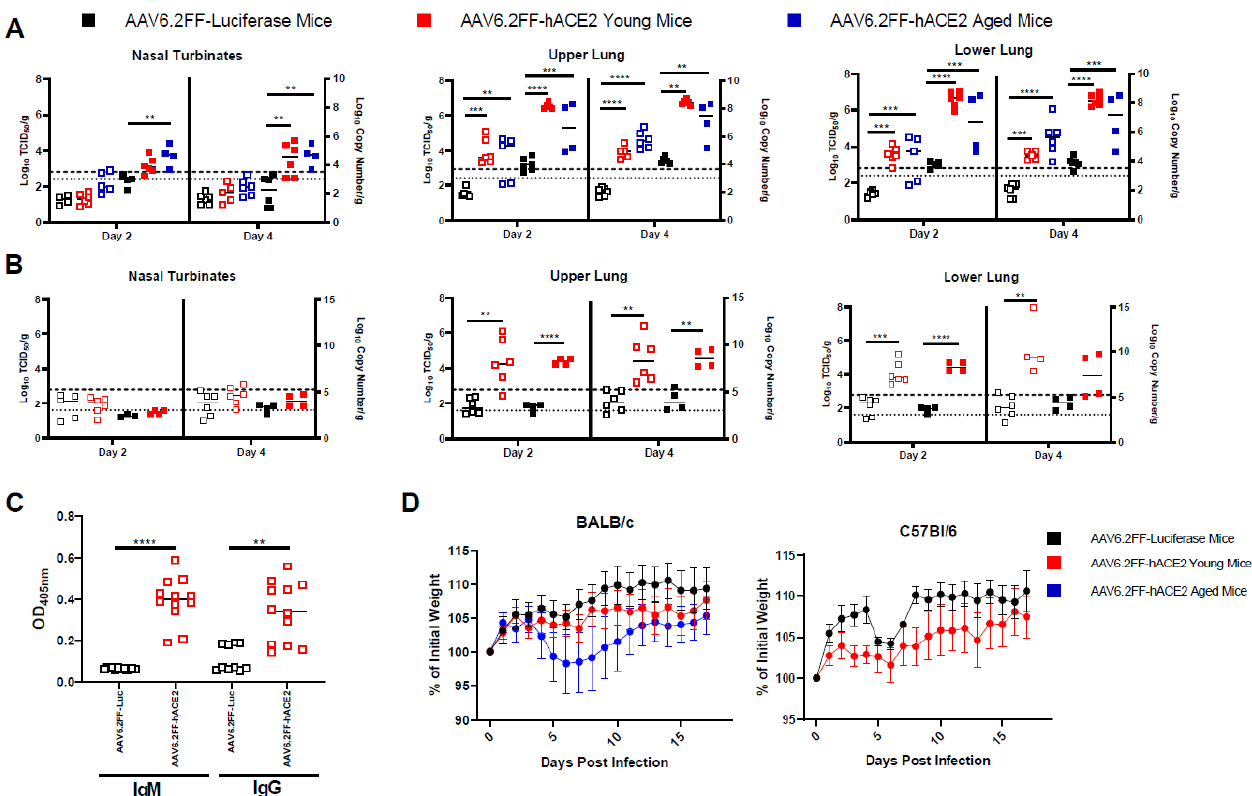
Figure 2. SARS-CoV-2 viral titers, weight loss, and antibody response in AAV transduced, infected mice. Infectious viral titers (open squares; left Y axis; dashed line is limit of detection (LOD)) or viral RNA copy numbers (filled squares; right Y axis; dotted line LOD) were detected in the nasal turbinates, upper lung, and lower lung of infected AAV6.2FF-Luciferase transduced mice (black symbols), or young AAV6.2FF-hACE2-transduced mice (red symbols), or aged AAV6.2FF-hACE2- transduced mice (blue symbols) in 6 mice (3 male, 3 female) per time point per group. ( A ) shows data for BALB/c mice, while ( B ) shows data for C57Bl/6 mice. ( C ) Anti-SARS-CoV-2 spike